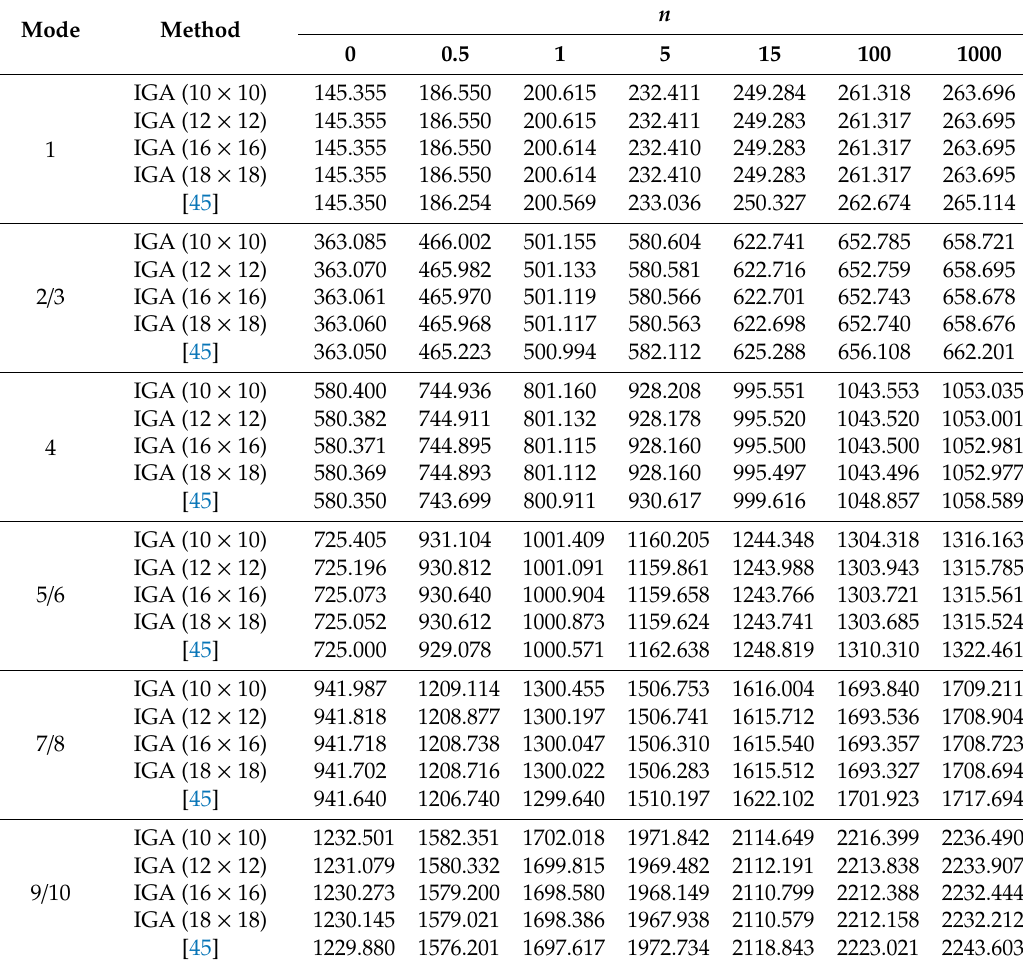
Table 2. The lowest 10 natural frequencies (Hz) of a SSSS PFGP with di ff erent control